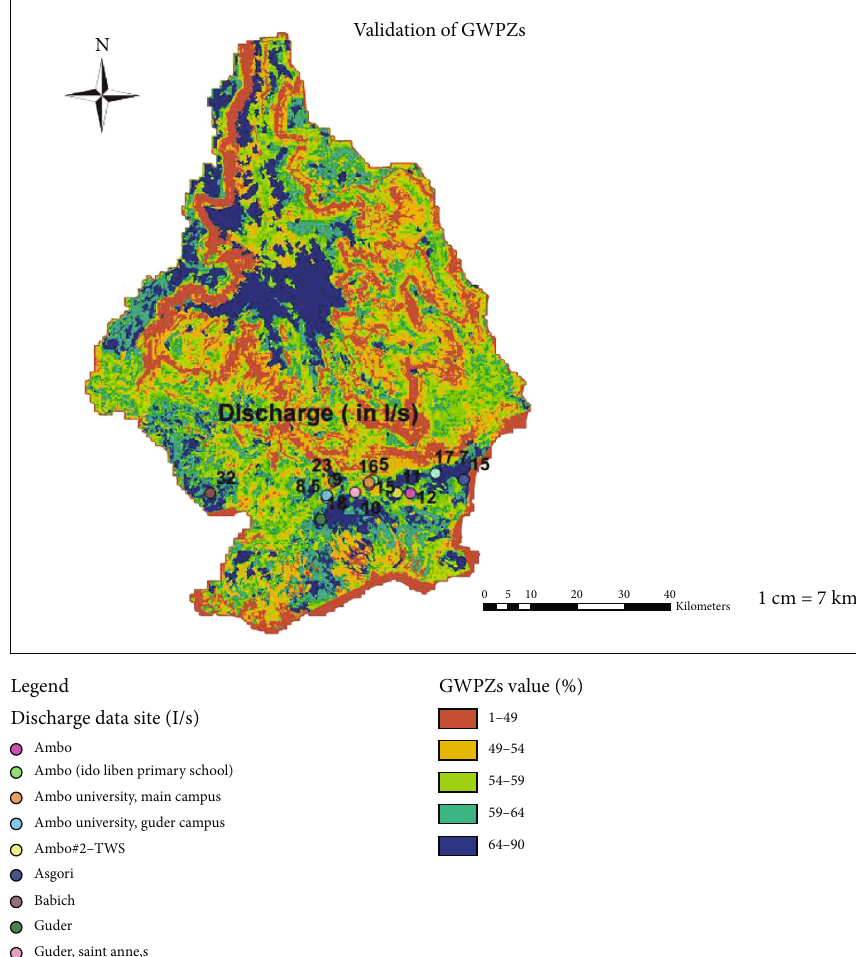
Figure 16: Validation map of GWPZs using well discharge data.